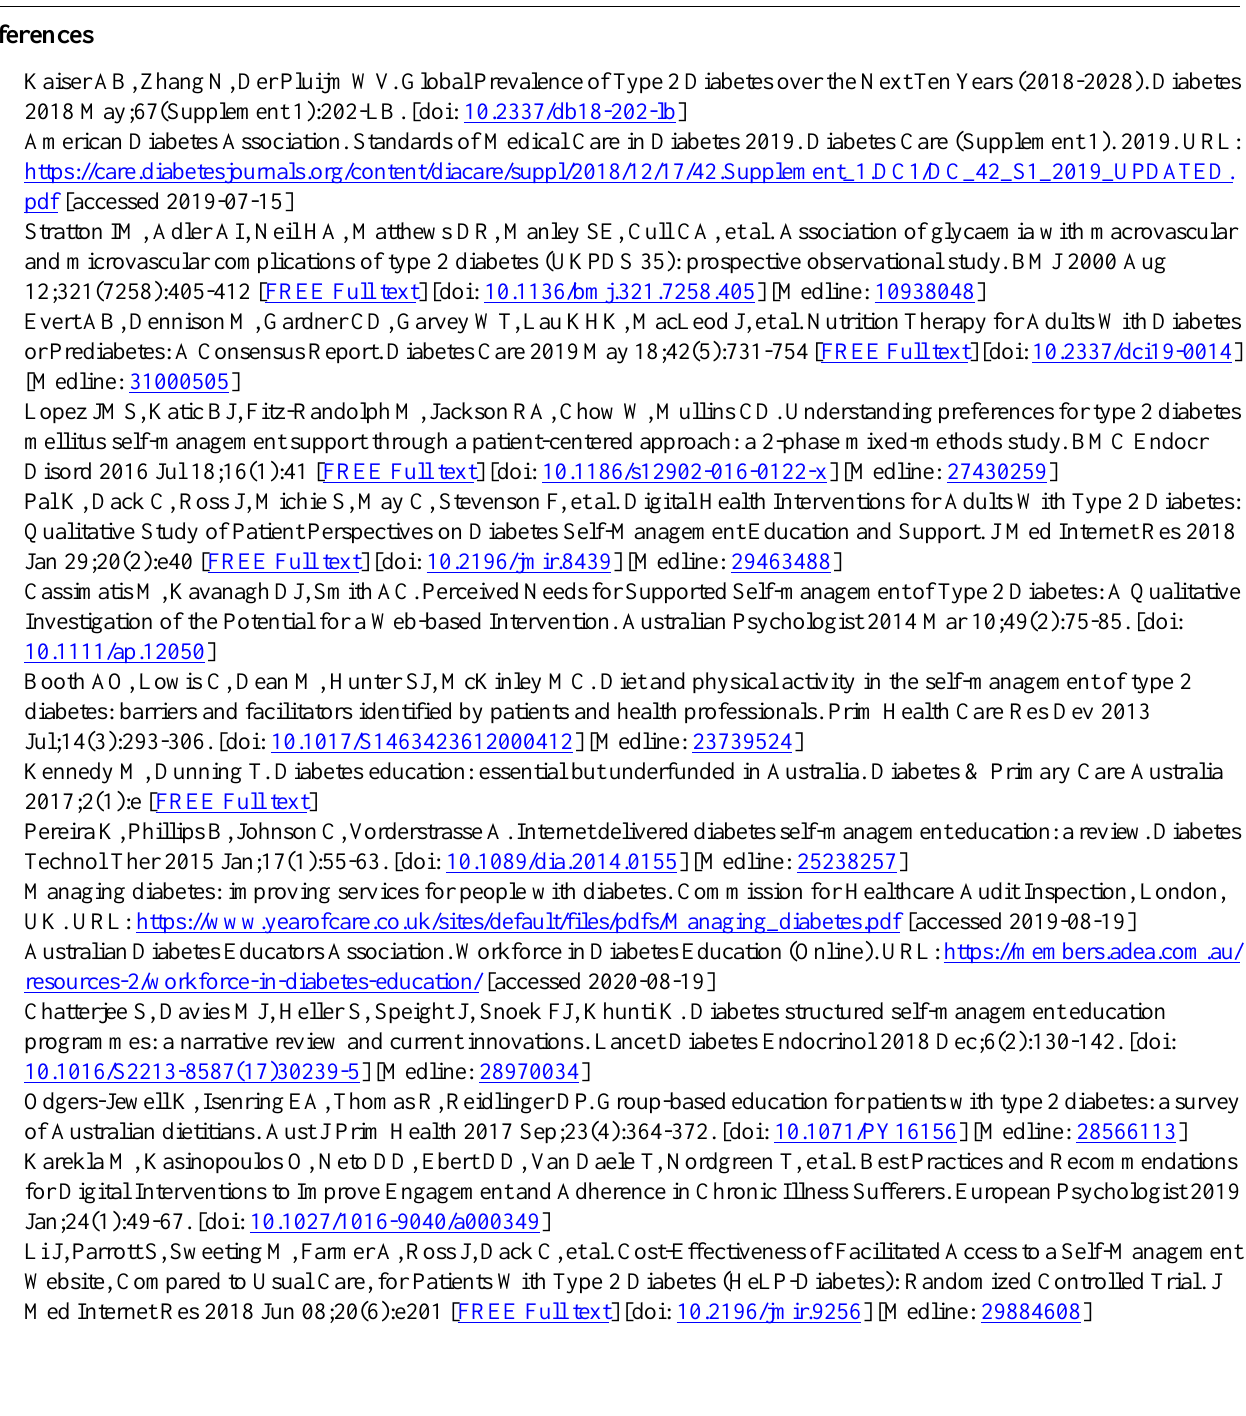
Table 5. Process evaluation